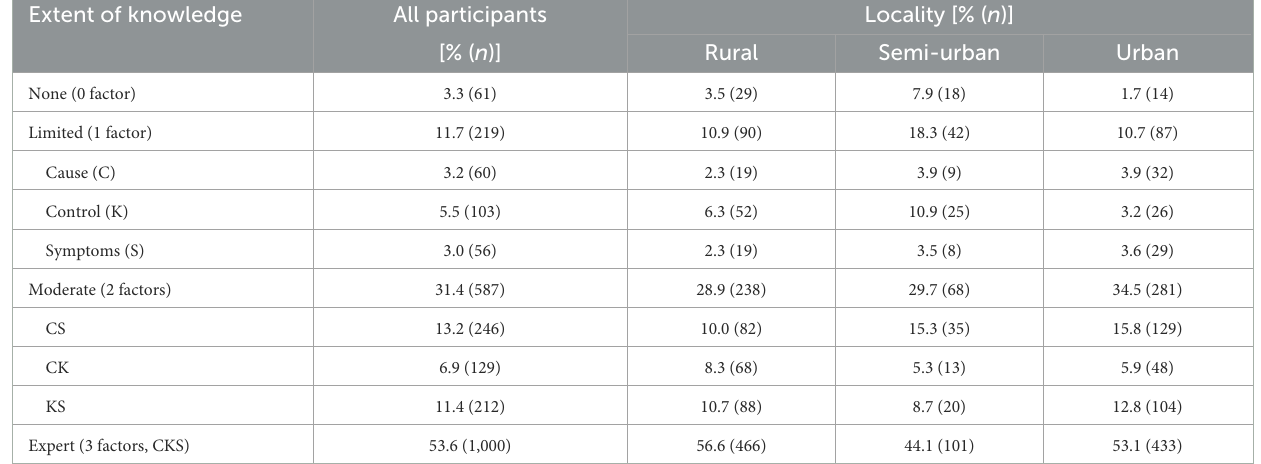
TABLE 4 Extent of knowledge of malaria in Cameroon ( n =